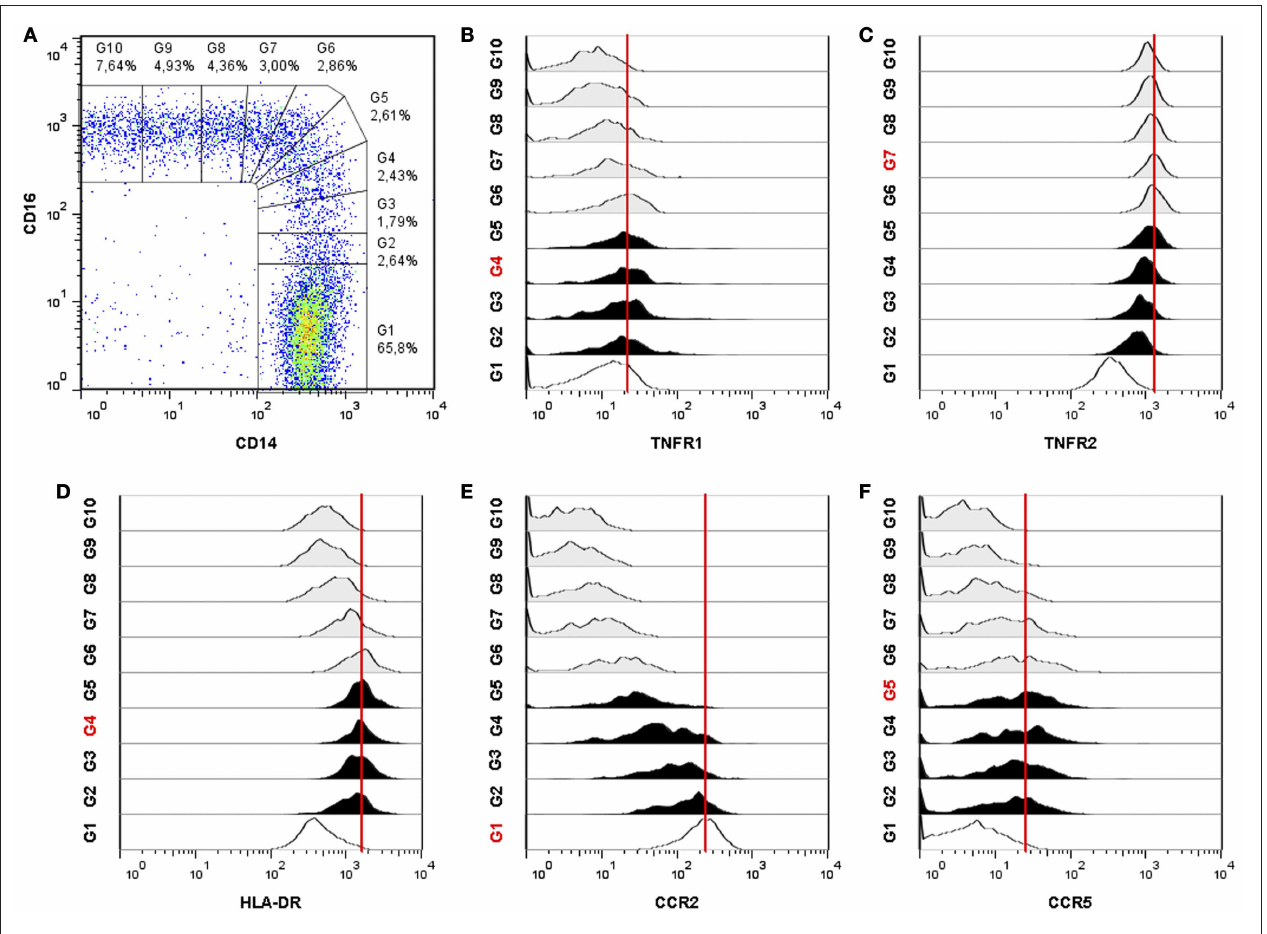
FiguRe 1 | Differential expression of TNFR1, TNFR2, HLA-DR, CCR2, and CCR5 on monocyte subsets of a sarcoidosis patient. (A) Monocytes are subdivided into 10 gates based on an increasing CD16 expression and a decreasing CD14 expression. Monocyte subset tracking stages of TNFR1 (B) , TNFR2 (C) , HLA-DR, (D) , CCR2 (e) , and CCR5 (F) . The red gate number and the